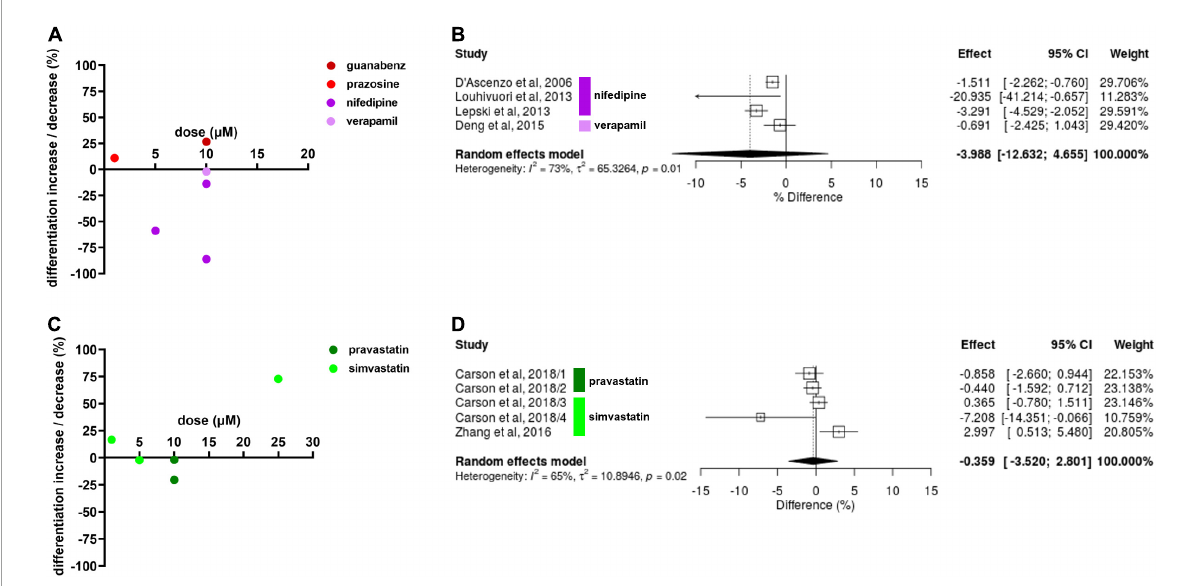
FIGURE3 Drug effects on neural stem cell (NSC) neuronal differentiation. (A) The effect of calcium channel blockers (CCBs) and α 2As on NSC differentiation. Percentage increase/decrease in NSC proliferation after exposure to varying doses compared to untreated controls. Note that the time of exposure differed from 5 to 14 days. (B) Forest plot showing the effect sizes of experiments reporting the effect of CCBs on NSC differentiation. No statistical significance was reached ( p = 0.37). (C) Effects of simvastatin and pravastatin on NSC differentiation after 3–6 days exposure. (D) Forest plot showing the effect sizes of reported from experiments investigating potential effects of simvastatin (1, 10, and 25 µ M) and pravastatin (10 µ M) on NSC neuronal differentiation. No statistically significant effect was revealed ( p =